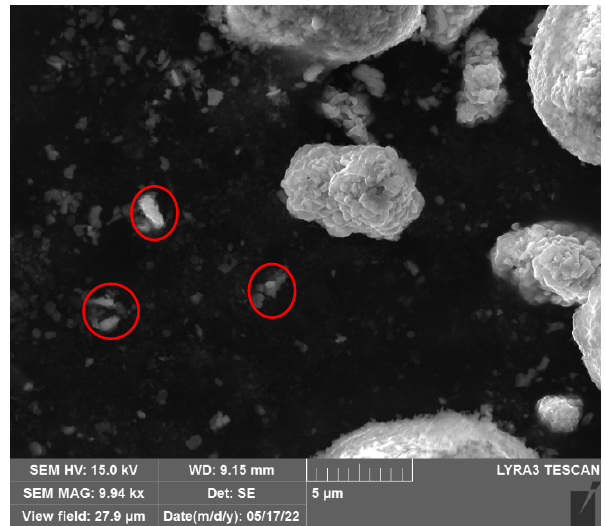
Figure 5. Materials in red circles seem to be the agglomerated LNO with sizes < 1 µ m produced during synthesizing, but has not participated in coating layer formation on the NMC-60